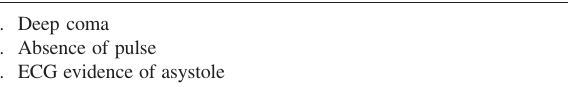
Table 4 - Criteria for cardiac death apply for